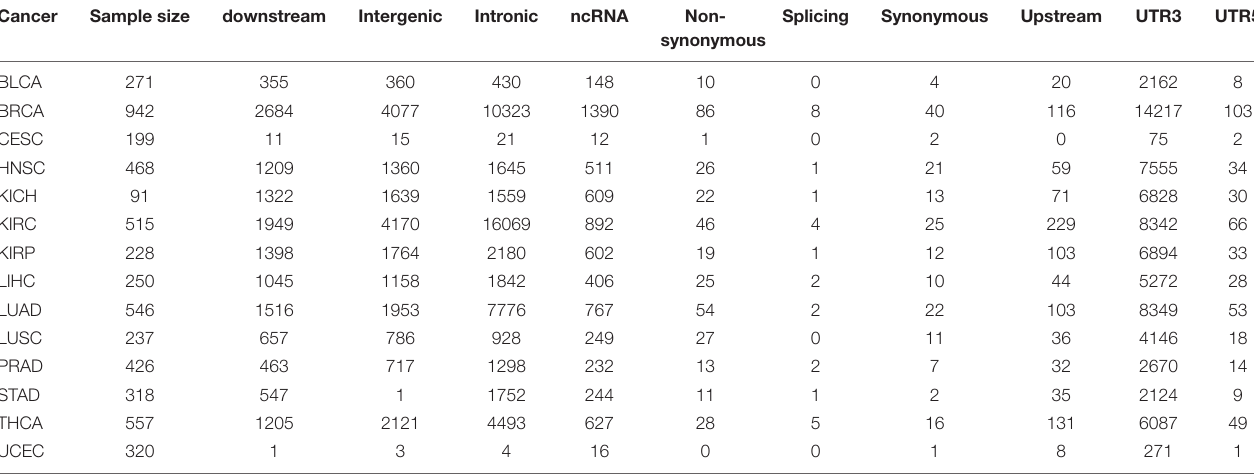
TABLE 1 | Differential edited positions by cancer and genomic position categories.